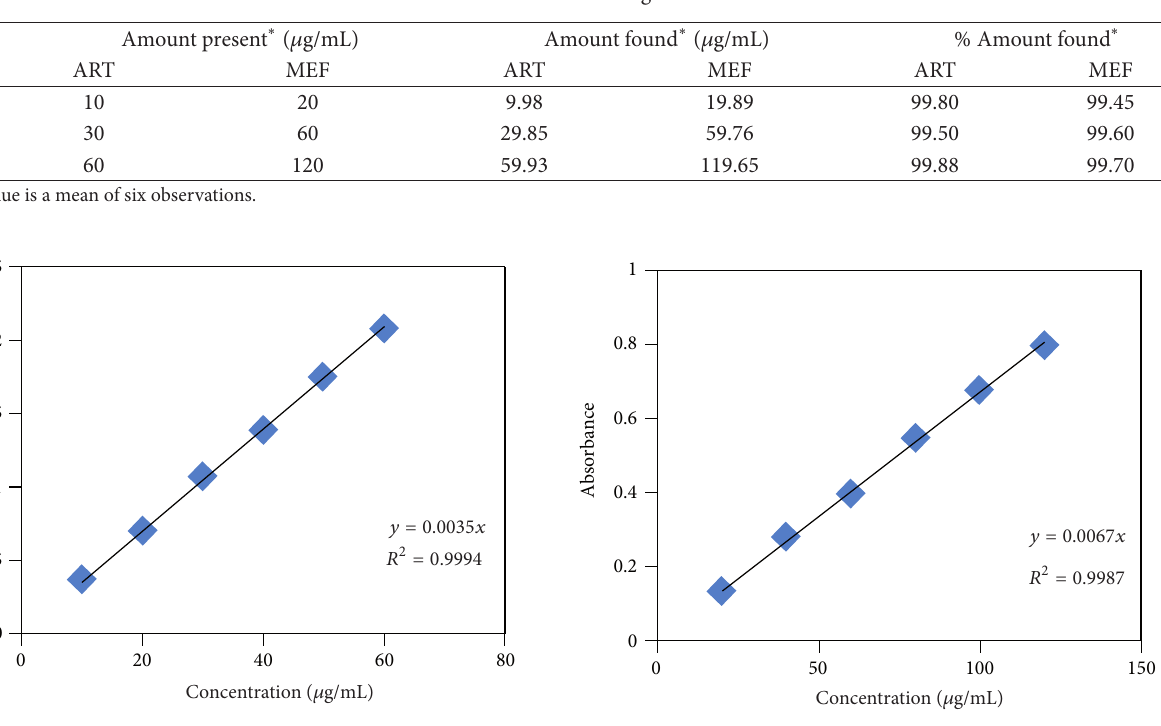
T 4: Results of mixture containing ART and MEF.